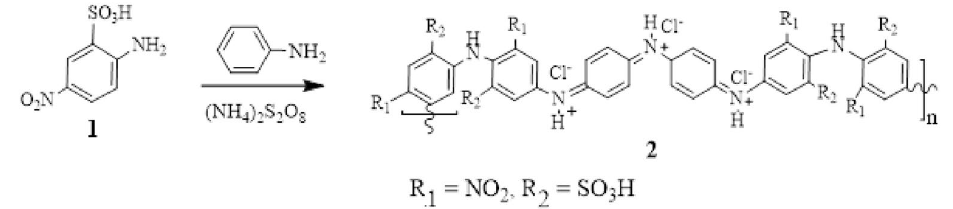
Figure 1. Chemical synthesis of aniline-catalyzed poly (5-nitro-2-orthanilic